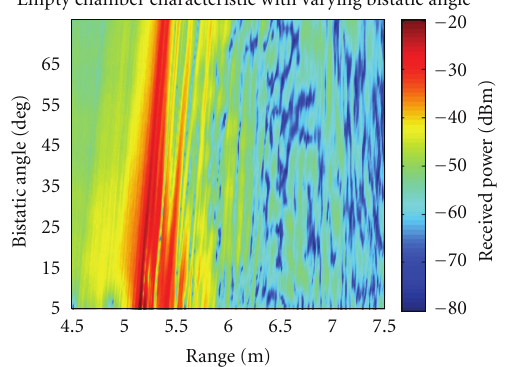
Figure 6: Empty chamber measurements for varying bistatic an- gles. Colour represents signal intensity in